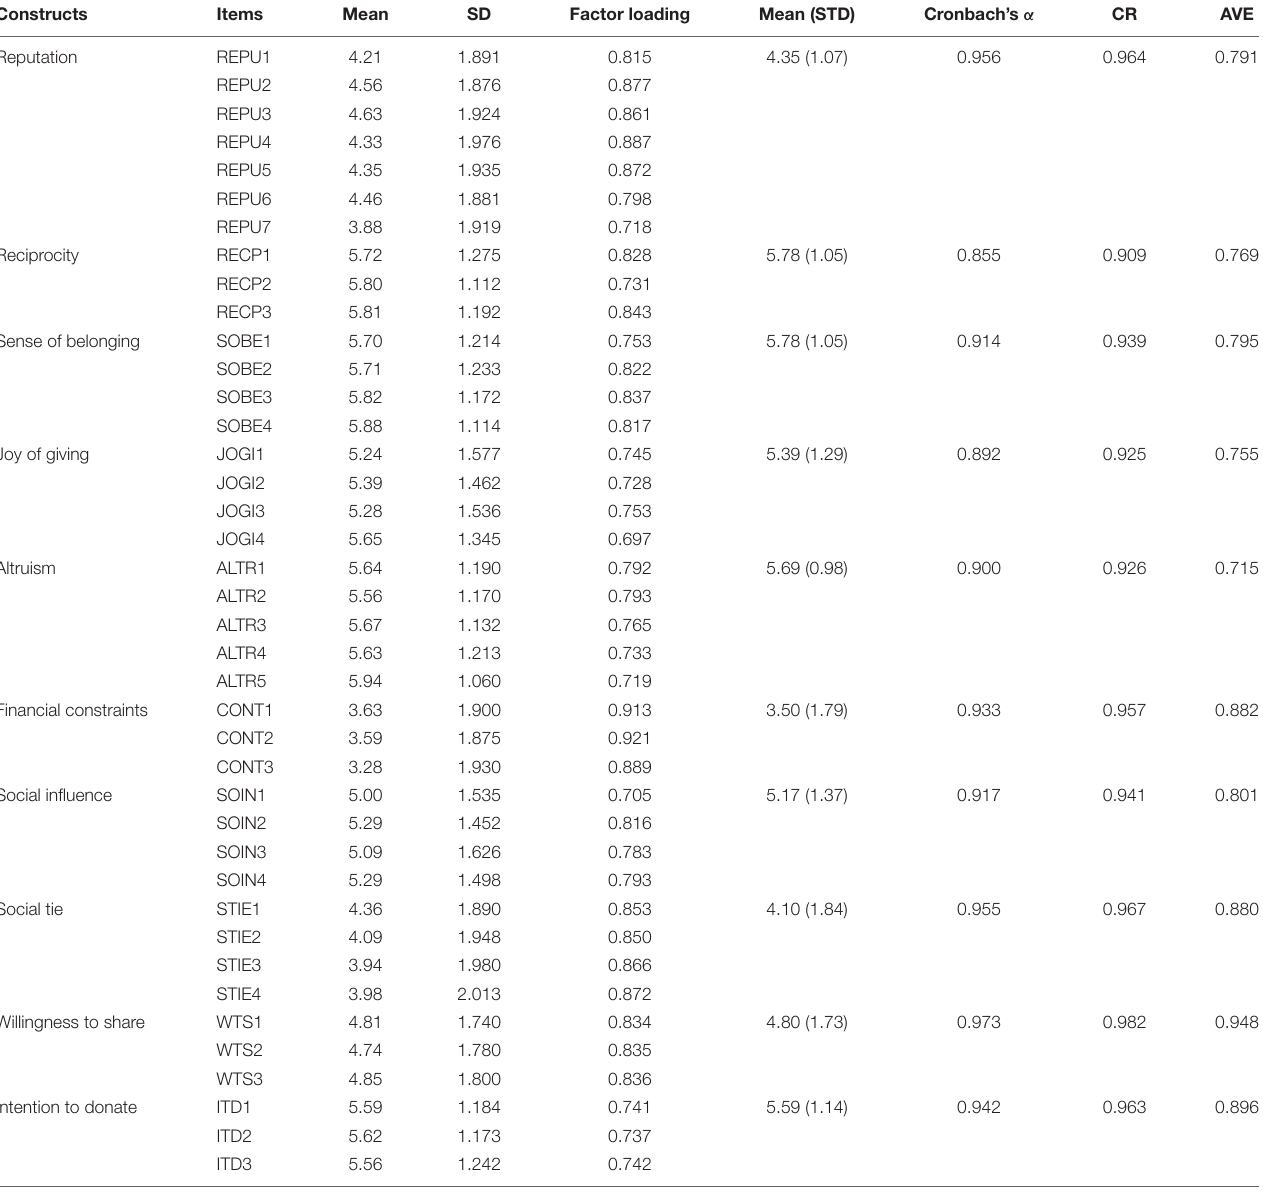
TABLE 2 | Construct reliability and convergent validity ( n =